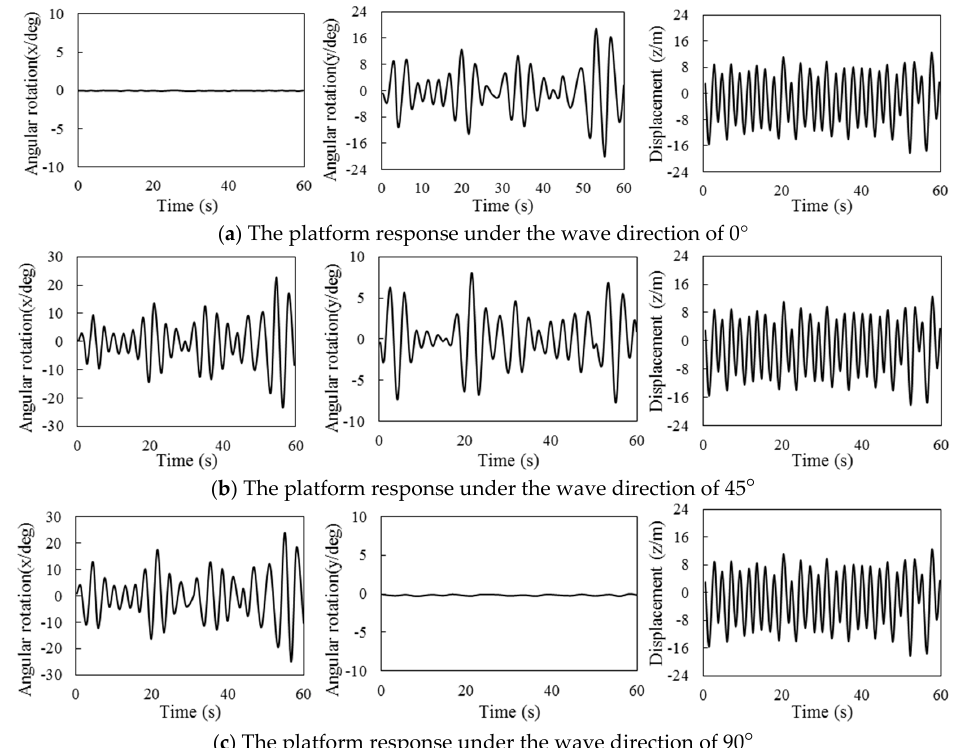
Figure 5. The platform response under wind − sea scale 3 with different wave directions.